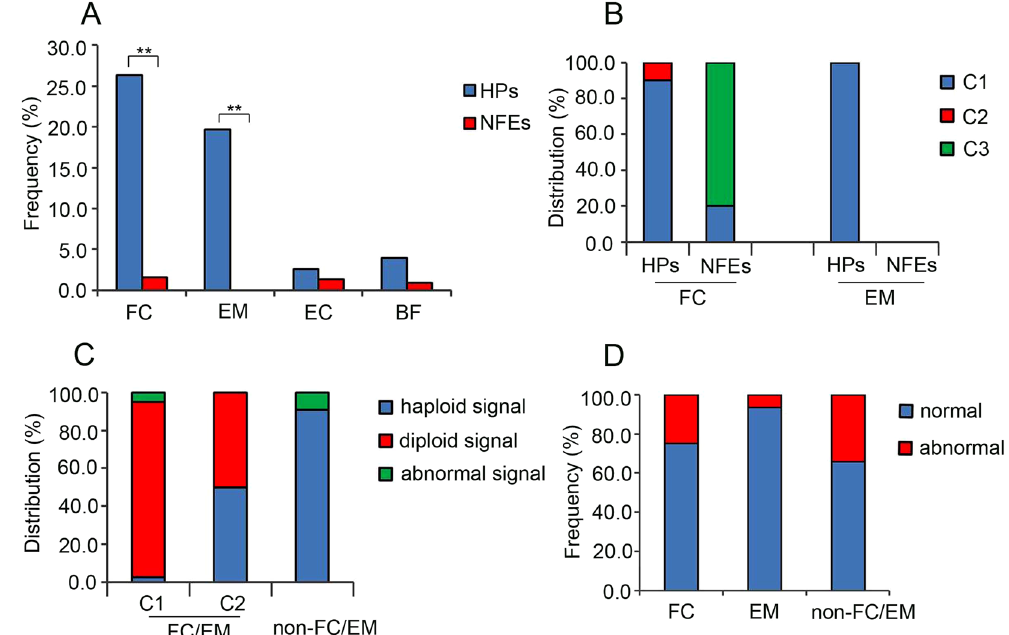
Figure 2. Characterization of FC/EM cleavage behaviours in HPs. ( A ) The frequency of FC/EM/EC/BF cleavage behaviours between HPs and NFEs; ( B ) The distribution of FC/EM during the first three cleavages between HPs and NFEs; ( C ) The percentage of haploid, diploid and abnormal signals appearing in FC/EM and non-FC/EM HPs; and ( D ) The percentage of normal and abnormal cleavages appearing in the next cell cycle between FC/EM and non-FC/EM HPs. HPs: haploid parthenotes, NFEs: normal fertilized embryos, FC: failed cytokinesis, EM: endomitosis, EC: endocycling, BF: blastomere fusion, C1: the first cell cycle, C2: the second cell cycle, C3: the third cell cycle. An asterisk indicates a significant difference by a t-test (P < 0.01).